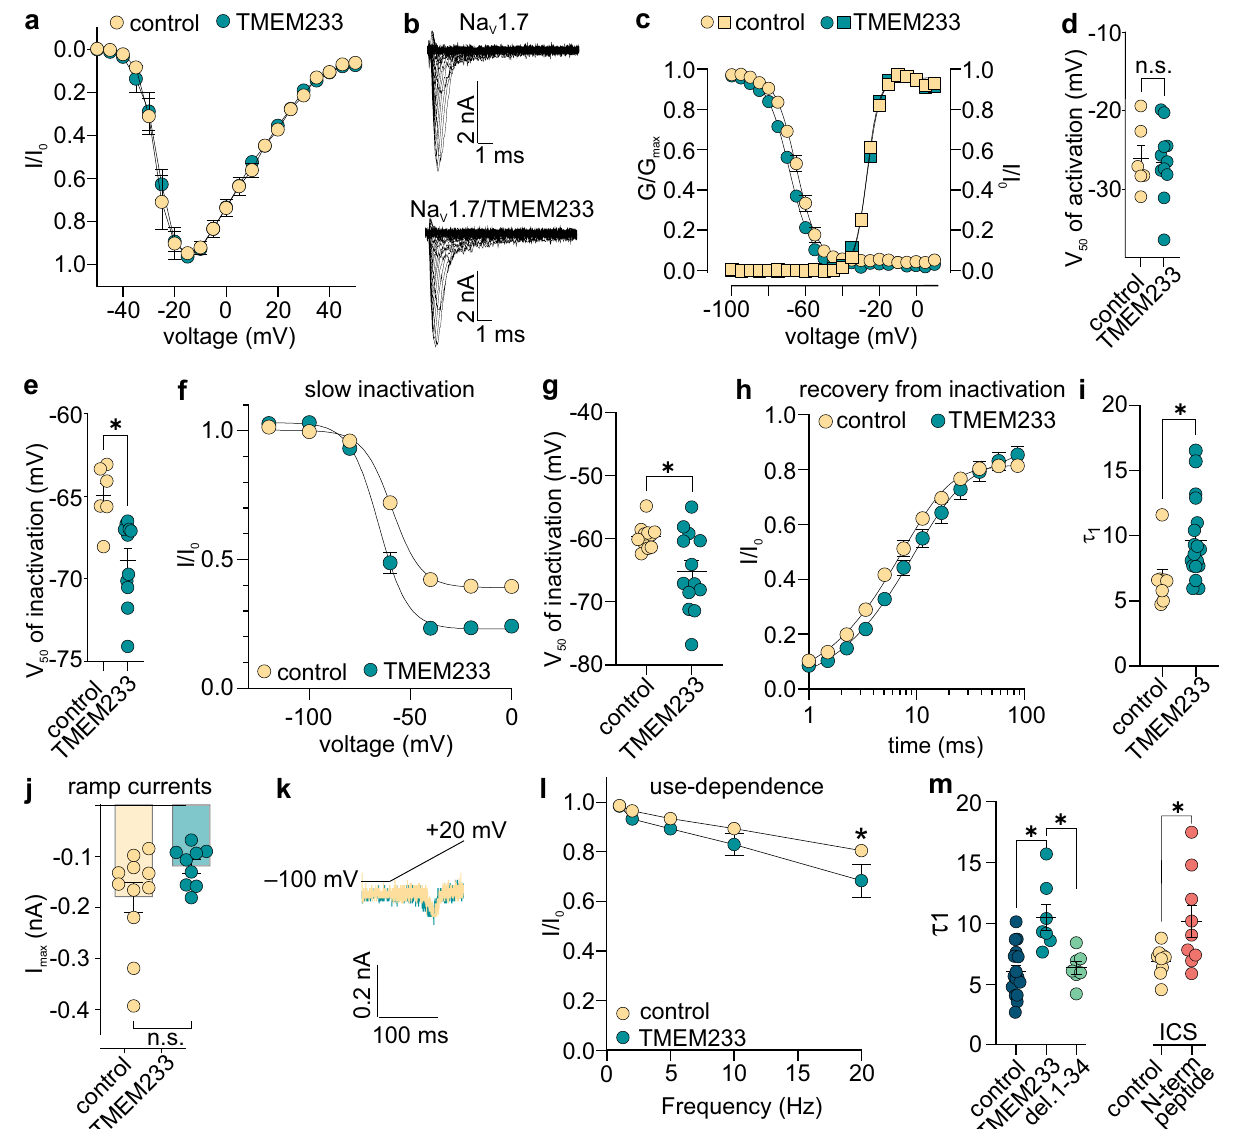
Fig.6|EffectsofTMEM233onNa V 1.7function.a Current-voltagerelationshipand ( b )familyofsampletracesfromhNa V 1.7( n =6)co-expressedwithTMEM233( n =11) in HEK293 cells. c Superimposed conductance – voltage (G – V, squares) and steady- state fast inactivation (circles) curves, of mock- (control, yellow) and TMEM233-